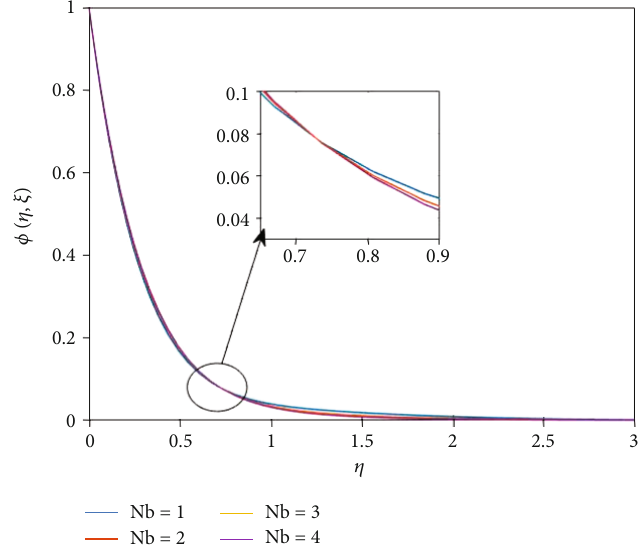
Figure 8: Concentration pro fi le for di ff erent values of r when De = 0 : 1, N = 0 : 5, n = 0 : 5, f δ = NR = 0 : 2, Sc = 0 : 6, and Pr = 1 :